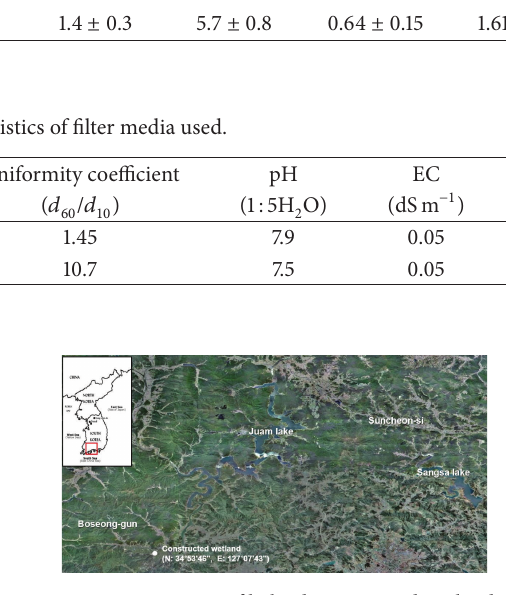
Figure 1: Location of hybrid constructed wetland.